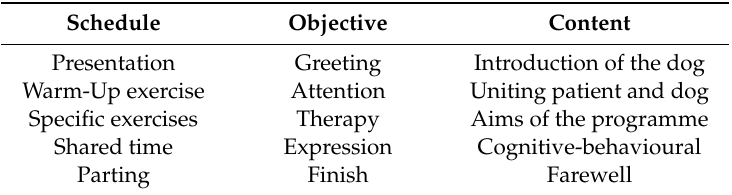
Table 1. Scheme of the sessions.